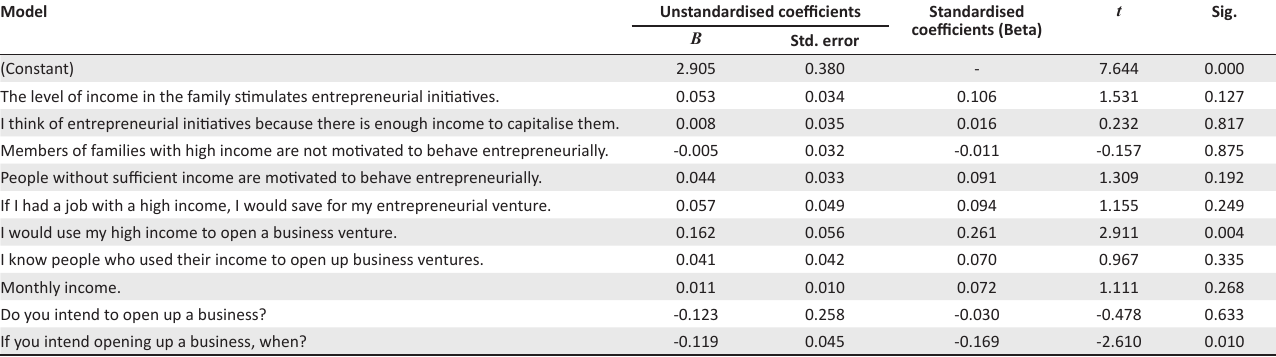
TABLE 6: Regression between income and entrepreneurial